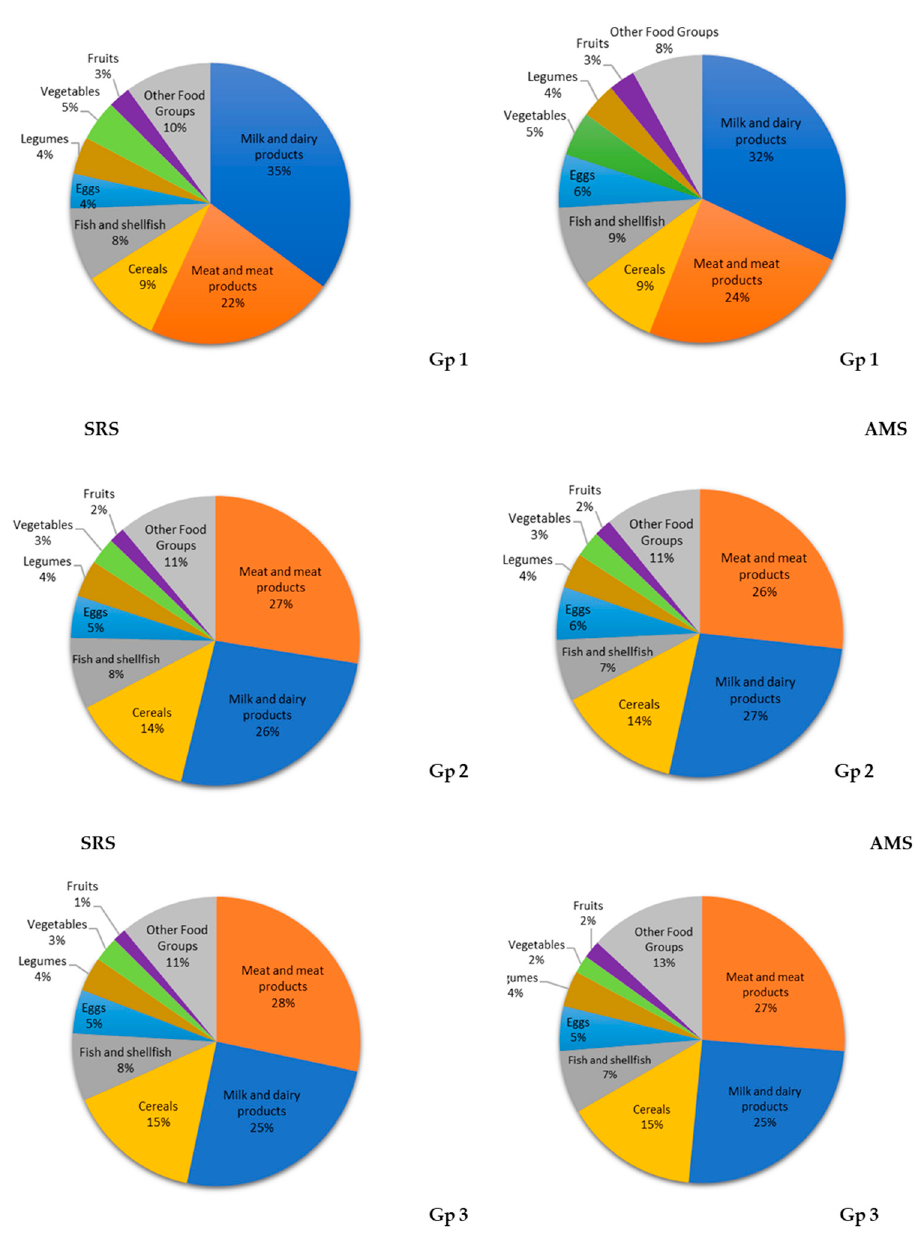
Figure 1. Contribution of the main eight food groups (in percentages) to total protein intake in the EsNuPI study population (Spanish reference cohort (SRS) and adapted milk consumer cohort (AMS)) according to age group (Gp 1), one to <3 years; (Gp 2), three to <6 years; and (Gp 3), six to <10 years. It is important to notice that, in the SRS cohort, liquid milk (cow, goat, and other mammal milk and fortified and adapted milk formulas) provided 54.1% of the total protein intake from the food group milk and dairy products, and in the AMS cohort, the fortified and adapted milk formulas contributed 50.8% of the total protein from the same food